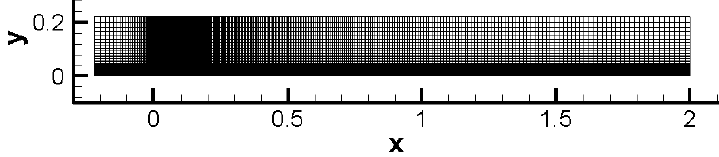
Figure 2. Mesh used for calibration.